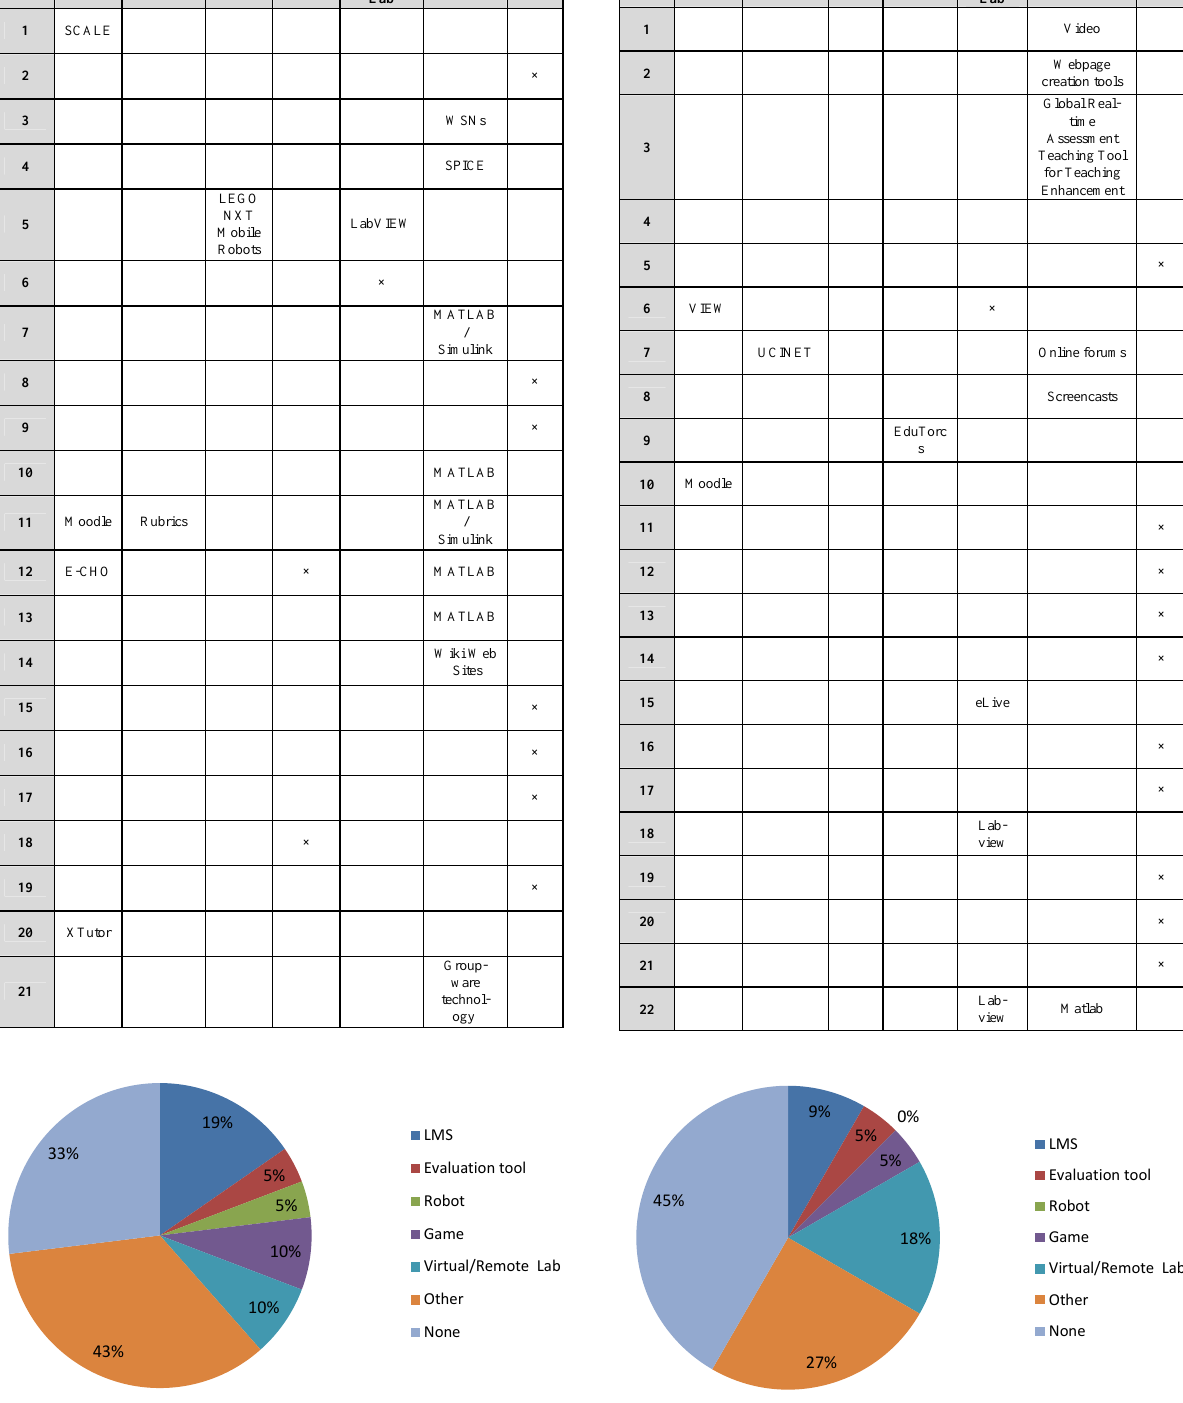
Figure 3. Technology Tool Dimensions, IEEE Transactions Vol. 54, N. 1